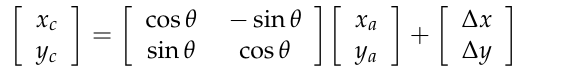
corresponding solder points in the workpiece can be obtained by Equation (10). After the actual position of the circuit board is obtained, the pixel position of the marking point in the image is used to convert the actual solder position into the galvanometer table processing coordinate system according to the conversion relationship between the pixel coordinate system and the galvanometer processing coordinate